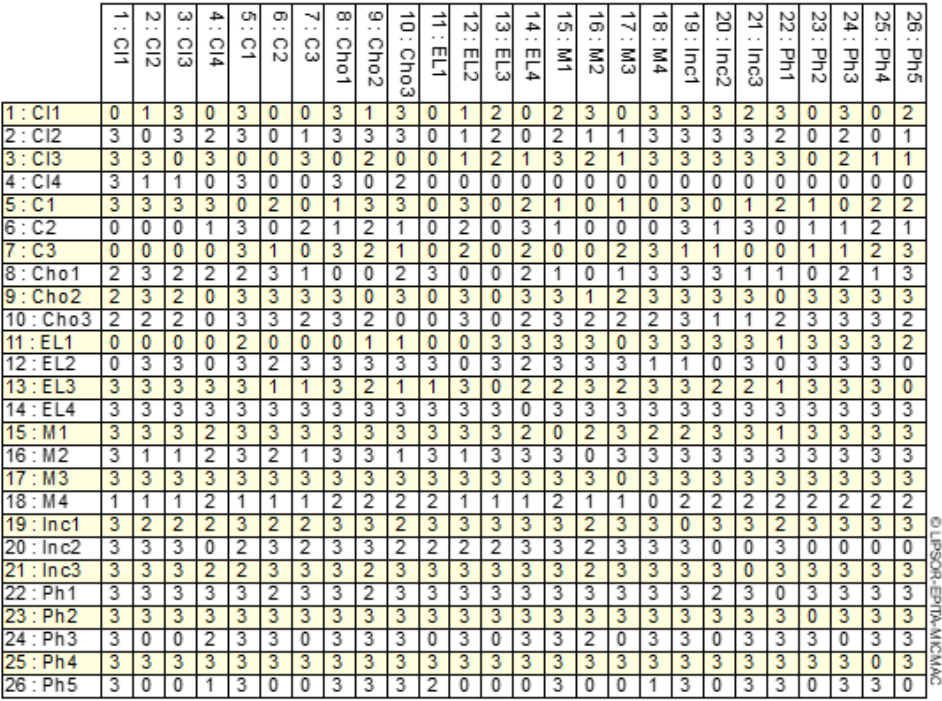
Figure 2. Reachability matrix (Direct Influence Matrix).